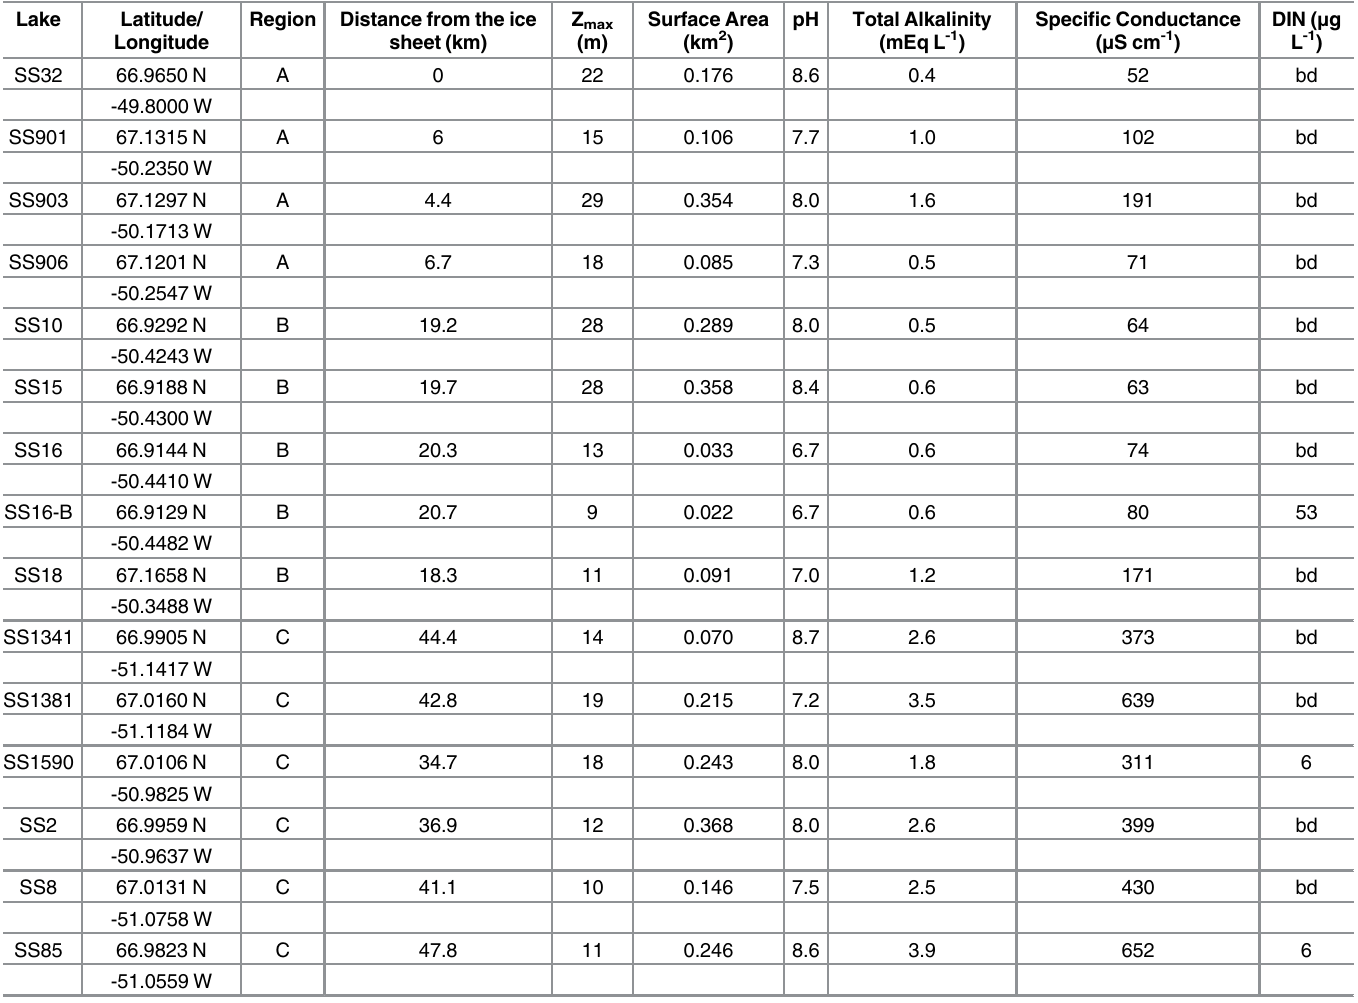
Table 1. Characteristics of the 15 lakes used in this study. Lake Latitude/ Region Distance from the ice Longitude sheet (km)